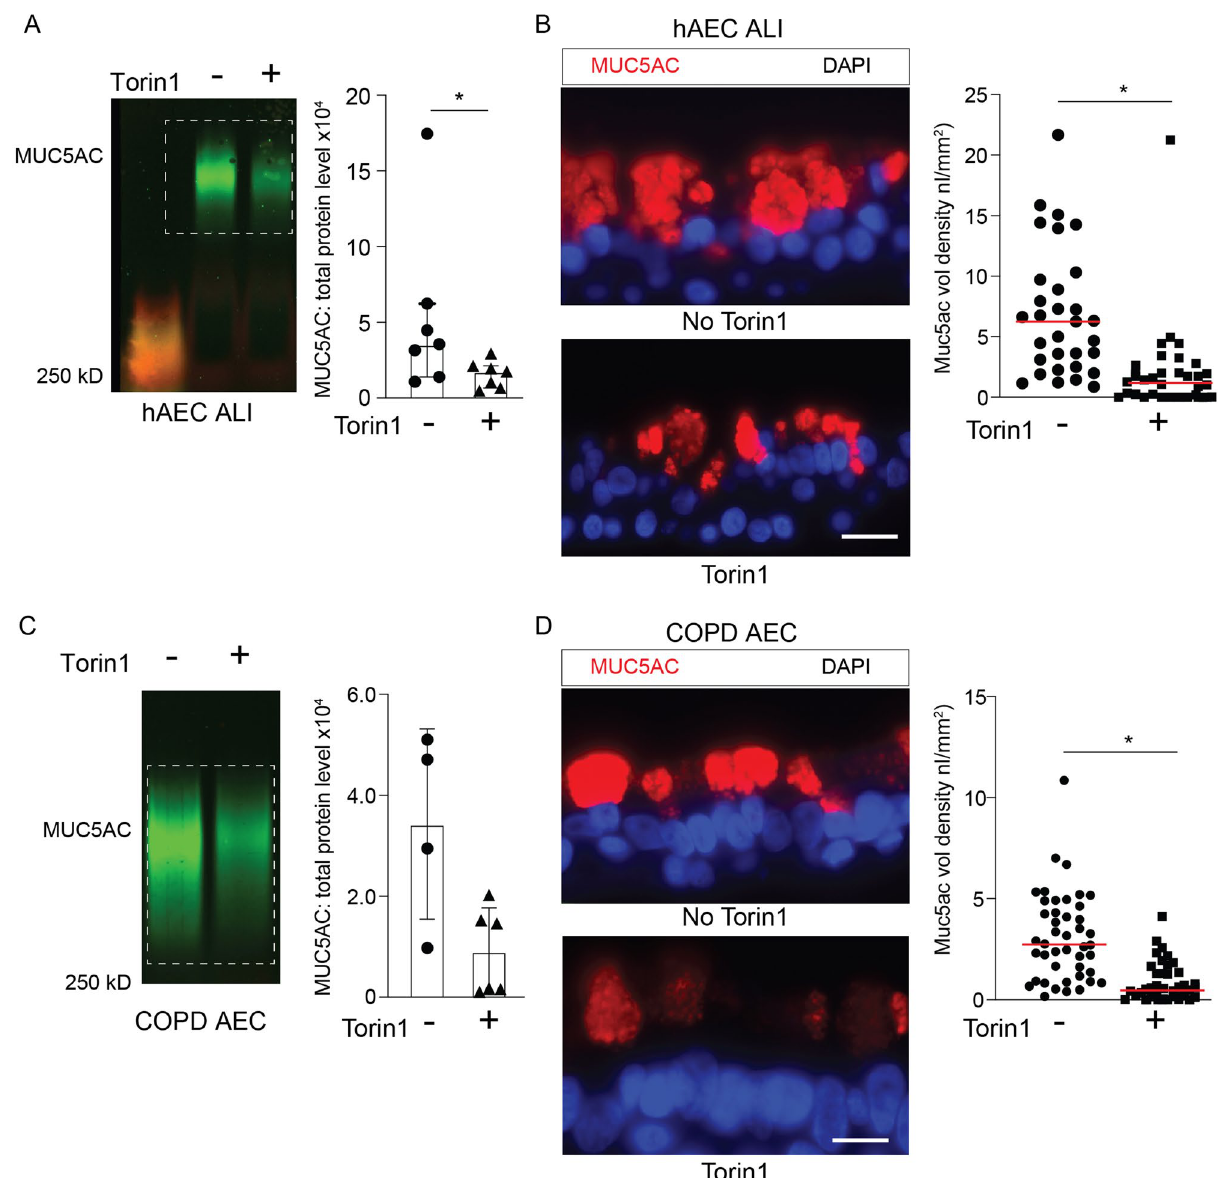
from human AECs under ALI condition derived from COPD explant airways. (n = 4 CTL and 6 torin1 treated inserts from 2 different lung explant donors) along with corresponding quantification to total protein levels. ( D ) Representative MUC5AC immunostaining in human COPD AECs under ALI conditions ± torin1 treatment (10 μM) for 18 h. N = 3 inserts from two different COPD donors with 12 microscope images taken per sample. Scale bar = 20 microns for ( B ) and ( D ). Graphs show scatter plots with median bar for mucin immunostaining and scatter plots with median bar and interquartile range for mucin blots. Significant difference by Mann Whitney test for mucin blot data in parts ( A ) and ( C ). Significant difference by unpaired T-test with * for torin1 difference for immunostaining data in parts ( B ) and ( D